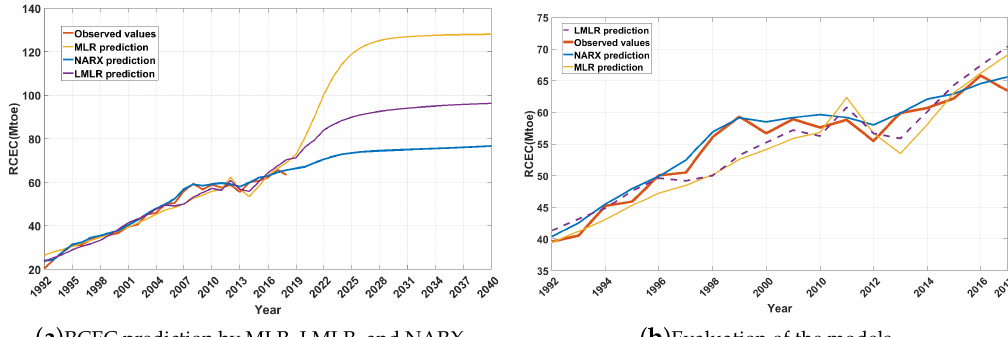
Figure 14. Models evaluation and RCEC